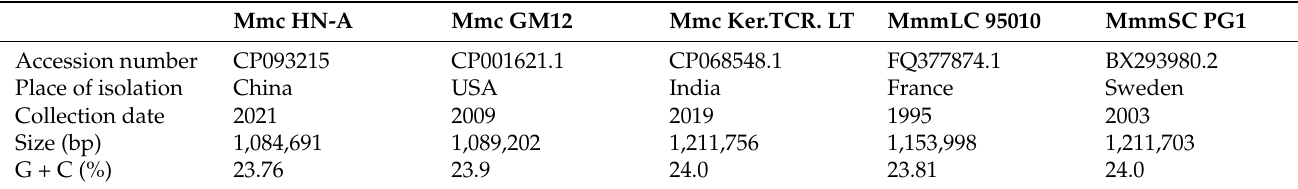
Table 3. Basic information of the five Mycoplasma mycoides strains.